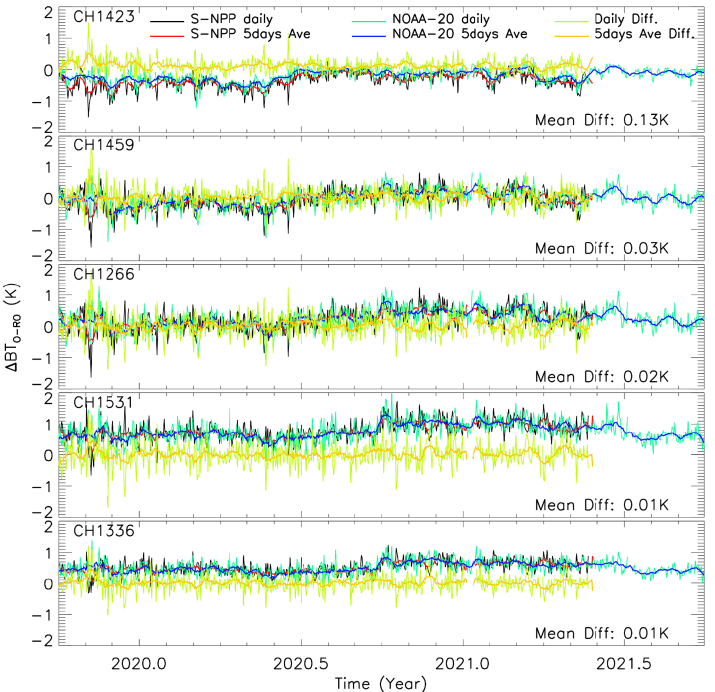
Figure 8. Same as Figure 7, except for results from selected CrIS channels in the MWIR band. UCAR implemented an update in the WETPf2 1DVAR algorithm on 25 September 2020.